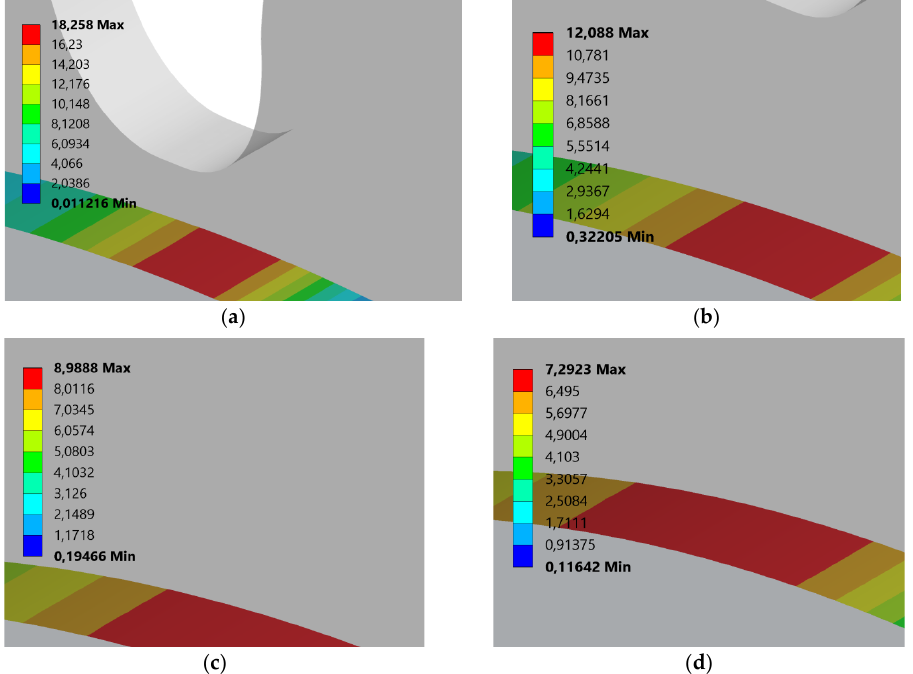
Figure 21. Shear stress results for hybrid gears with α d = 25° for different RTs; ( a ) 0.5 xm, ( b ) 1 xm, ( c )